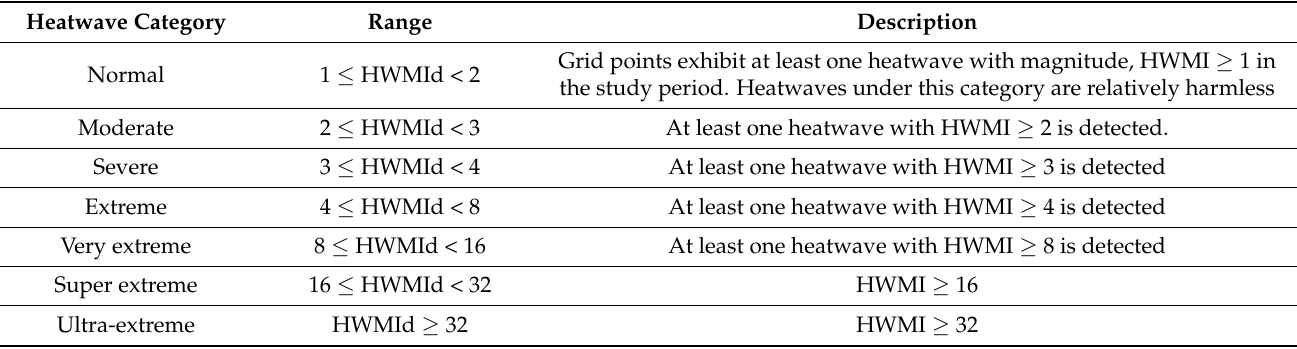
Table 2. Classification of Heatwave Magnitude Index daily